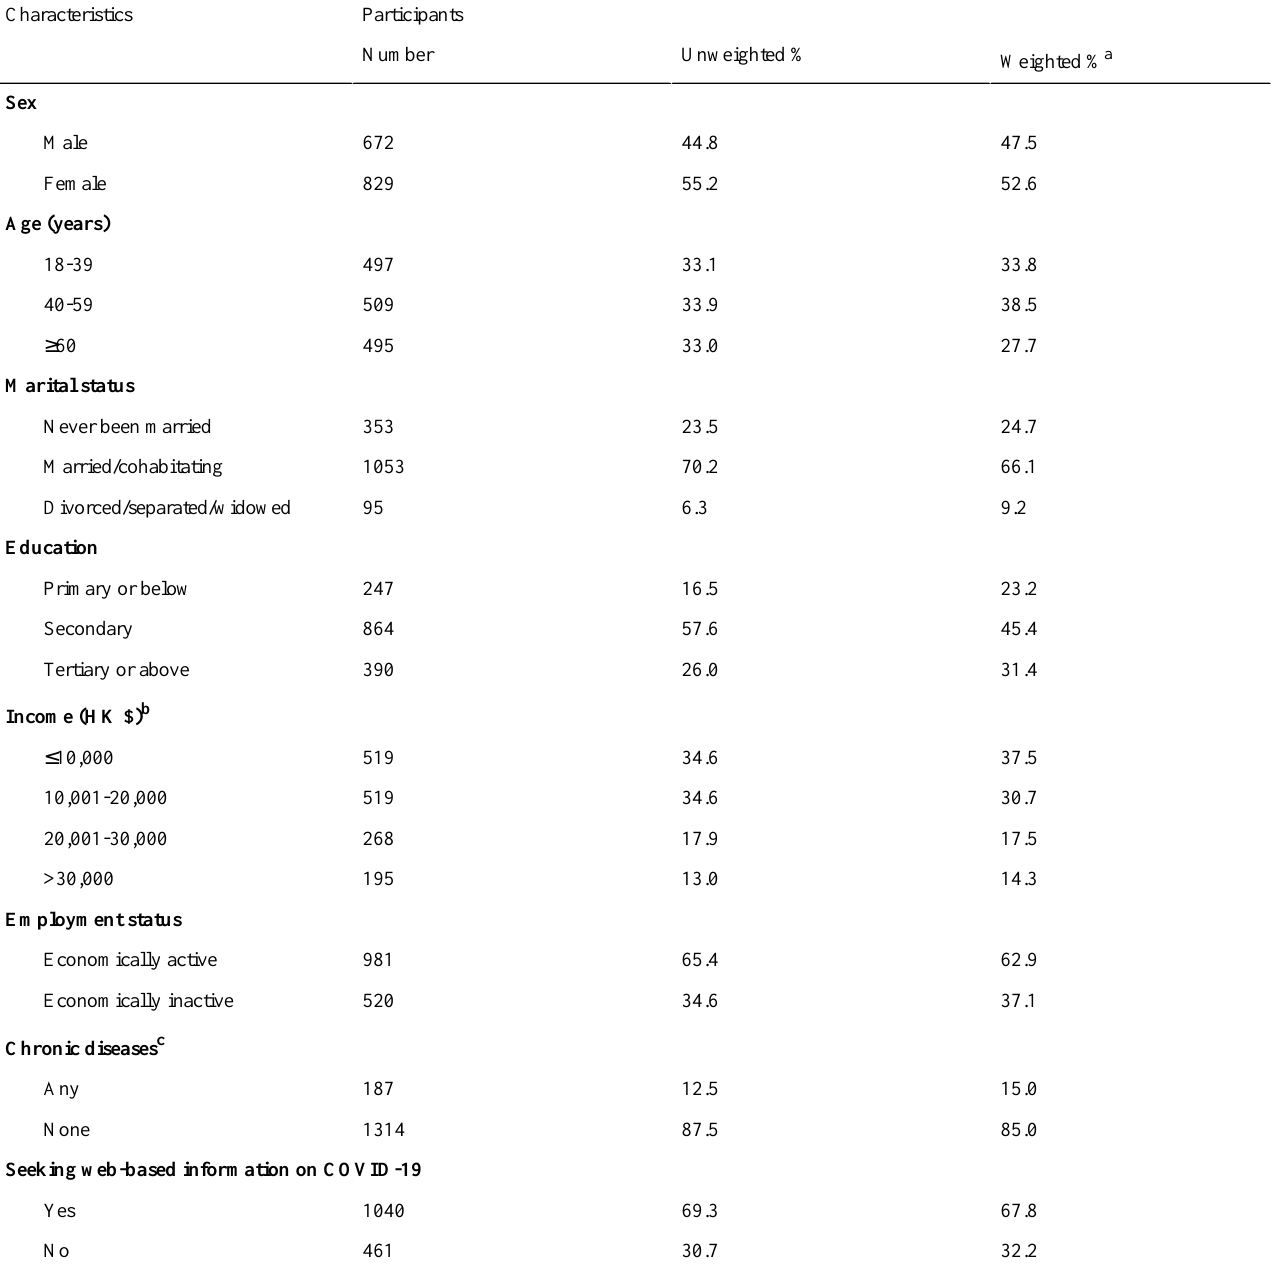
Table 1. Demographic characteristics, socioeconomic status, chronic disease outcomes, and seeking of web-based information on COVID-19 among the study participants